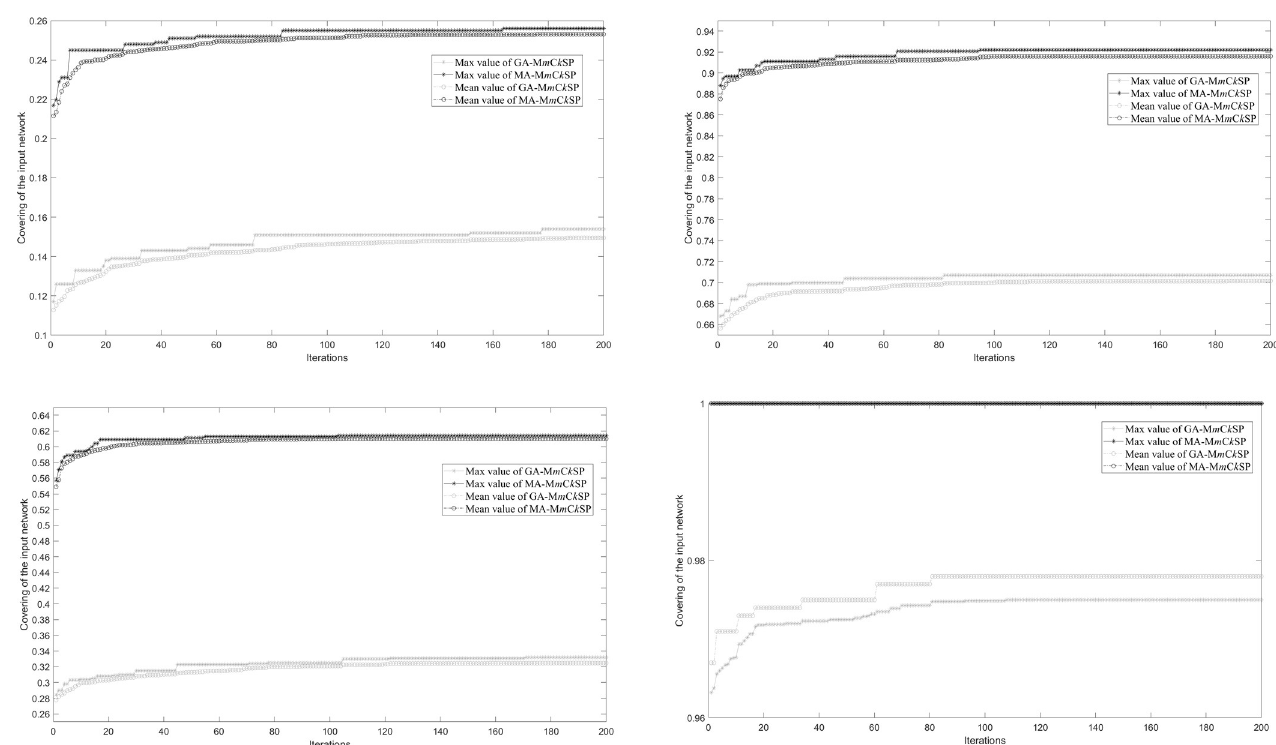
Fig 10. Covering of the input random network with GA-M m C k SPand MA-M m C k SPfor each iteration. Figures (a)-(d) are, respectively, the results for the settings k = 10 and m = 10, k = 10 and m = 30, k = 30 and m = 10, k = 30 and m = 30. The solid line with the stars represents the maximum value of the ten-runs experiment, while the dashed-dotted line with the circles represents the mean value. Grey and black, respectively, represent the results of GA-M m C k SPand MA-M m C k SP.